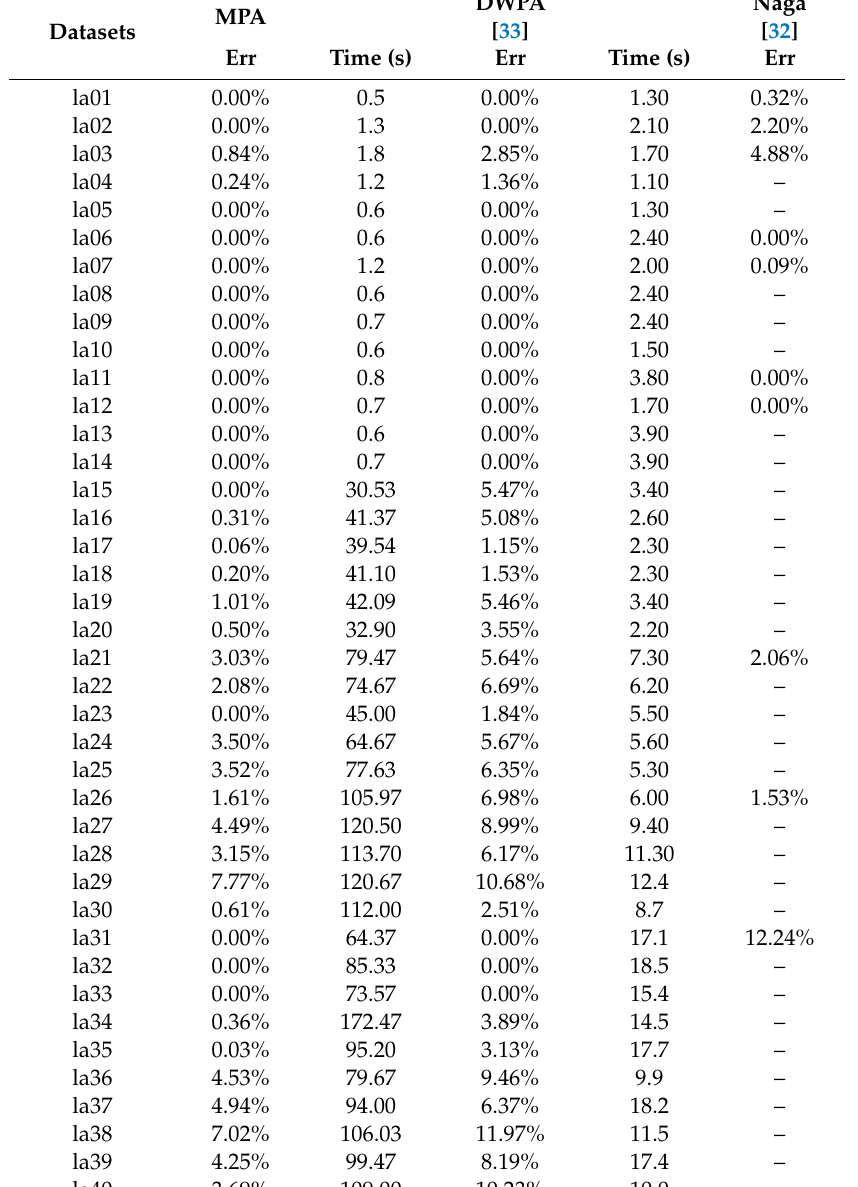
Table 8. Comparison of MPA performance with other methods for the analyzed JSSP